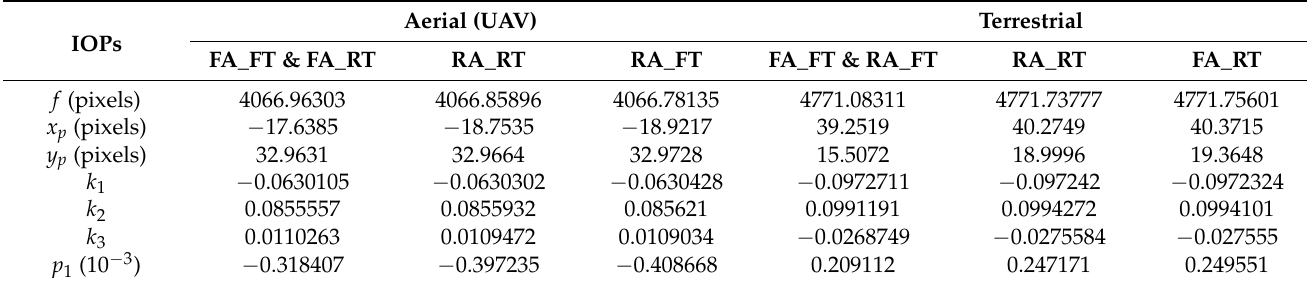
Table 6. IOPs of aerial (UAV) and terrestrial images after the BA of the Verwaltung dataset using different SC